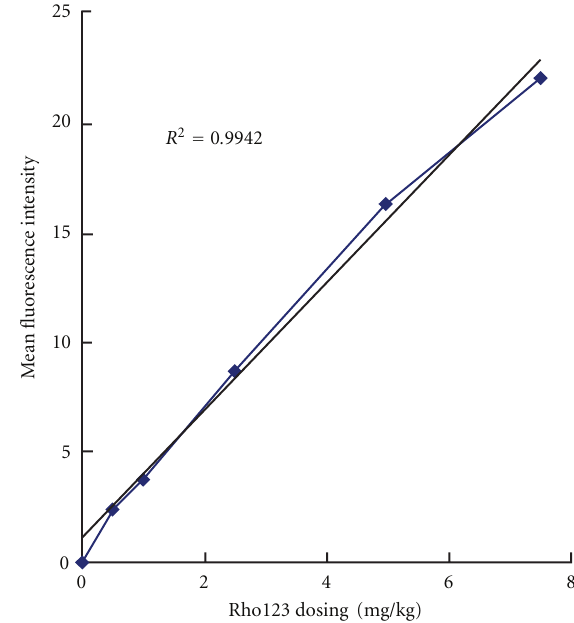
Figure 2: Mean fluorescence intensities of CD8 + cells were linearly correlated to the dose of Rho123 administered ( r 2 = 0 . 9942). The treatment protocol and experimental procedures are described in the text. Responses to treatments were significantly di ff erent from each other ( P < .